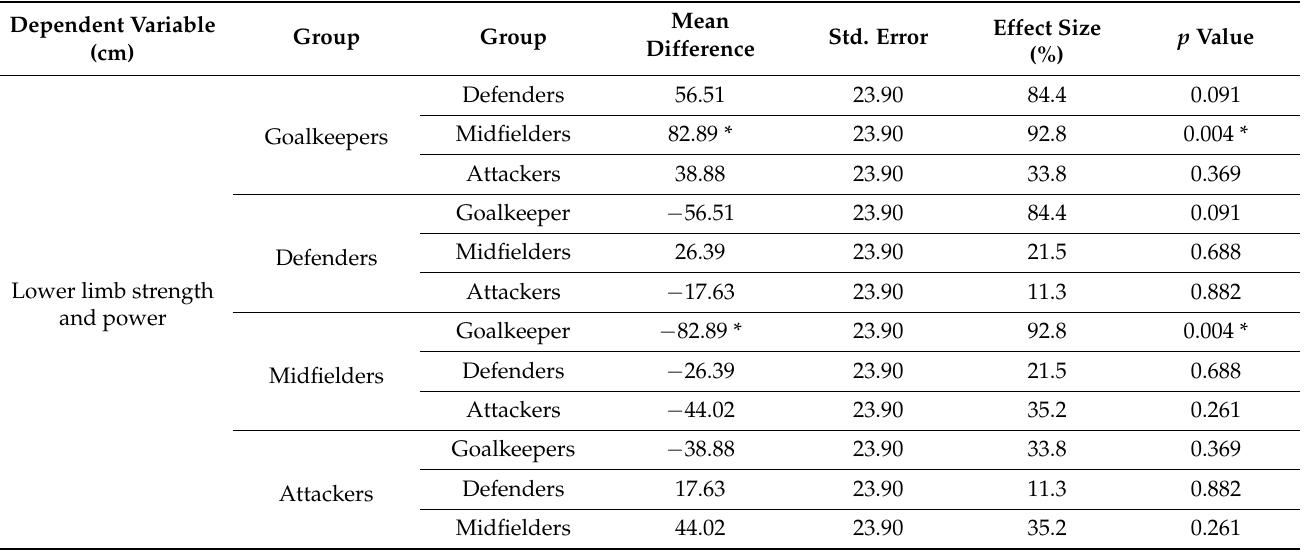
Table 7. Post-Hoc (Tukey) analysis of lower limb strength and power values of soccer players for their playing